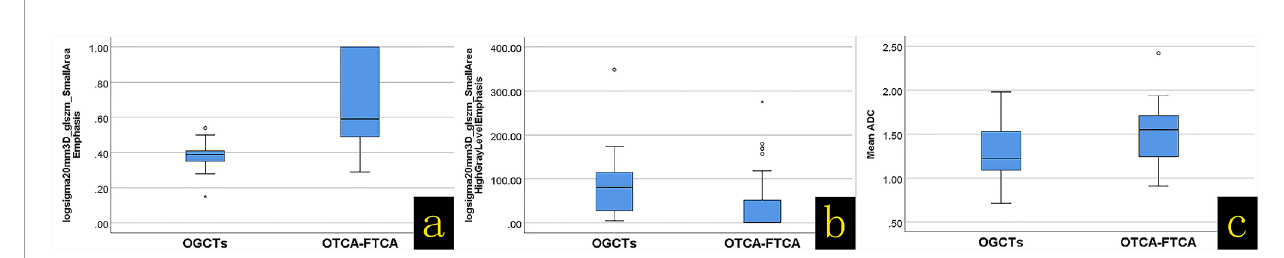
FIGURE 5 | (A) Box-and-whisker plot of the Log-sigma-2-0mm 3D_glszm_SmallAreaEmphasis difference between OGCTs and OTCA – FTCA. (B) Box-and-whisker plot of the Log-sigma-2-0mm 3D_glszm_SmallAreaHighGrayLevelEmphasis difference between OGCTs and OTCA – FTCA. (C) Box-and-whisker plot of the Mean ADC difference between OGCTs and OTCA – FTCA.